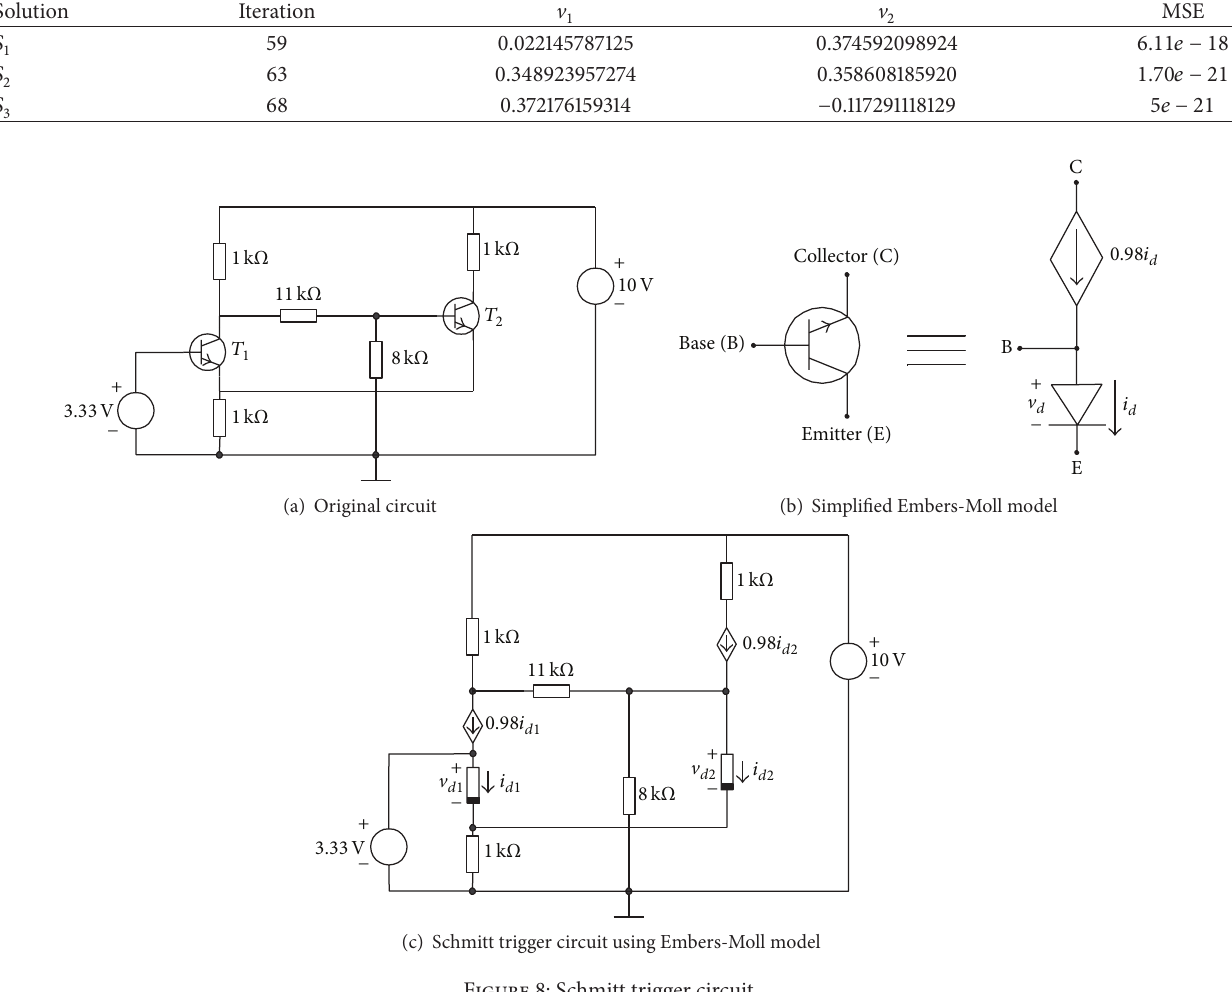
Figure 8: Schmitt trigger